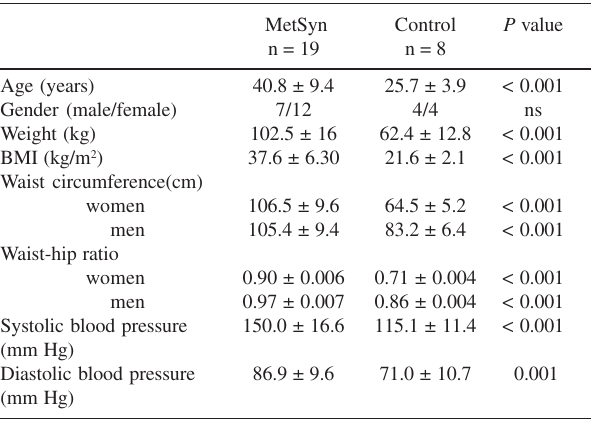
Table 1 - General characteristics of control and metabolic syndrome (MetSyn) groups